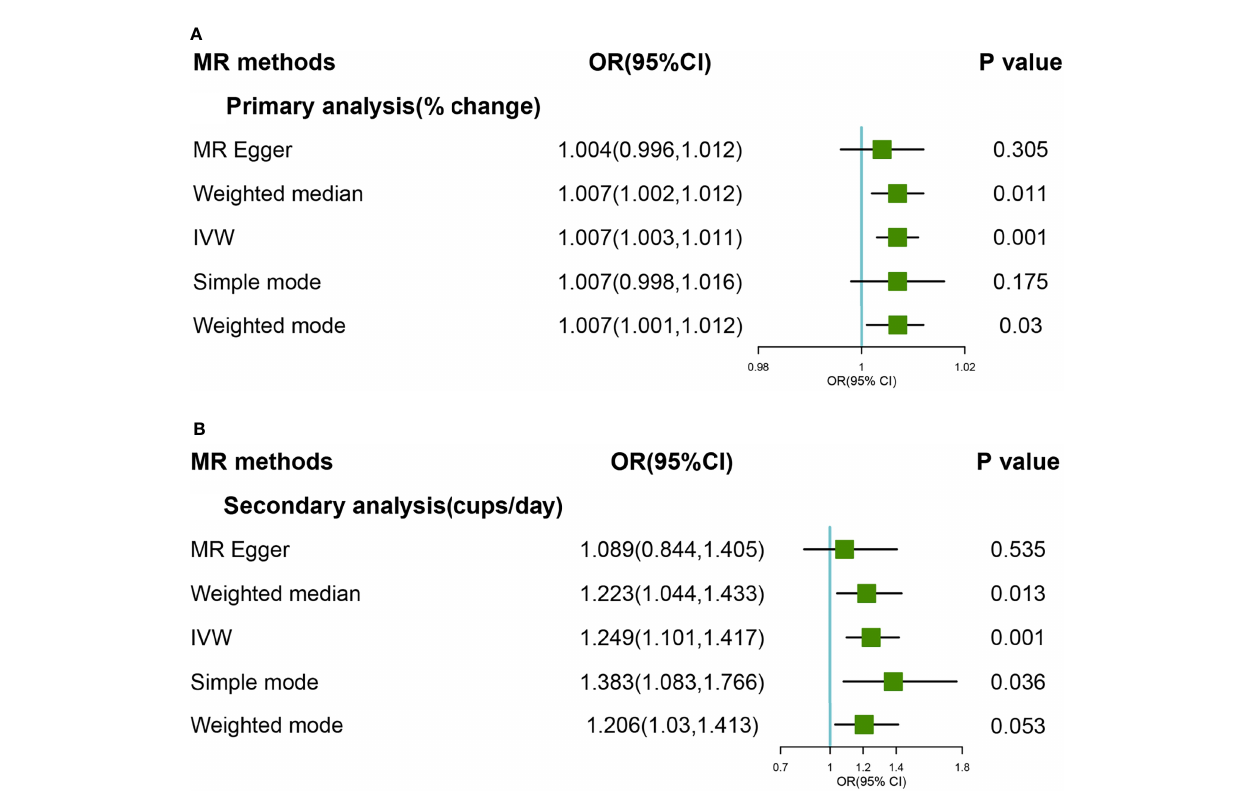
FIGURE 4 | Forest plot of MR study using (A) primary genetic instruments with self-reported OA. MR, Mendelian randomization; OR, odds ratio; CI, con fi dence interval; IVW, inverse variance weighted; OA, Osteoarthritis. Forest plot of MR study using (B) secondary genetic instruments with self-reported OA. MR, Mendelian randomization; OR, odds ratio; CI, con fi dence interval; IVW, inverse variance weighted; OA,